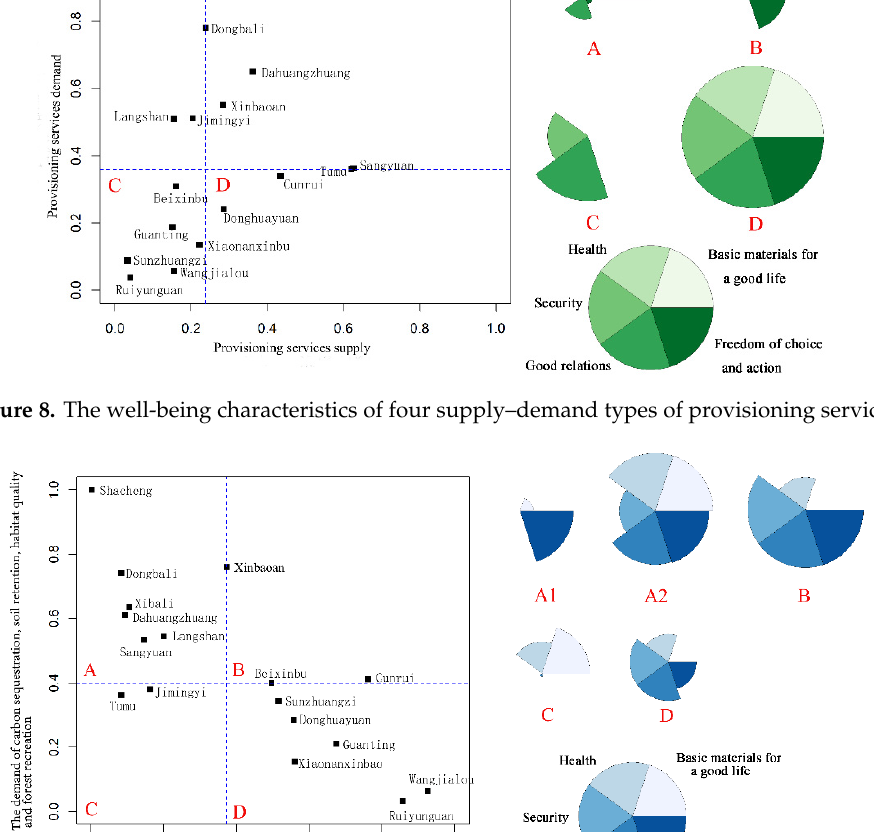
Figure 8. The well ‐ being characteristics of four supply–demand types of provisioning services.